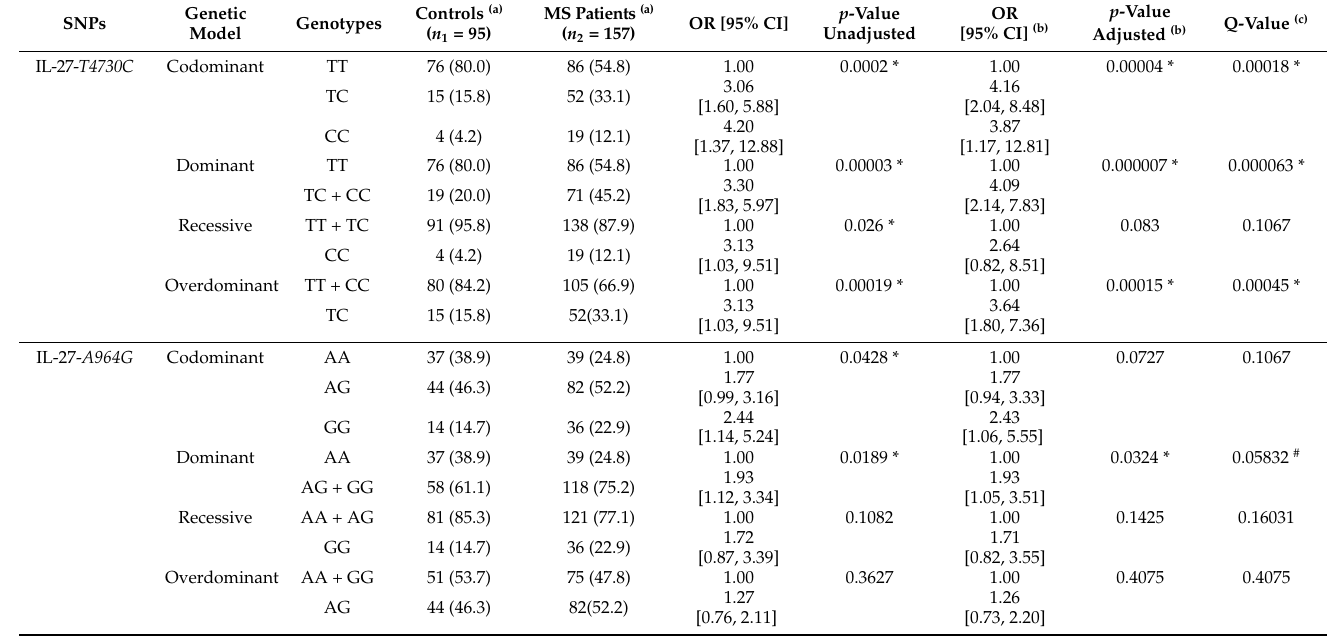
Table 3. Allelic and genotypic distributions of SNPs of IL-23 and IL-27 gene polymorphisms in MS patients and